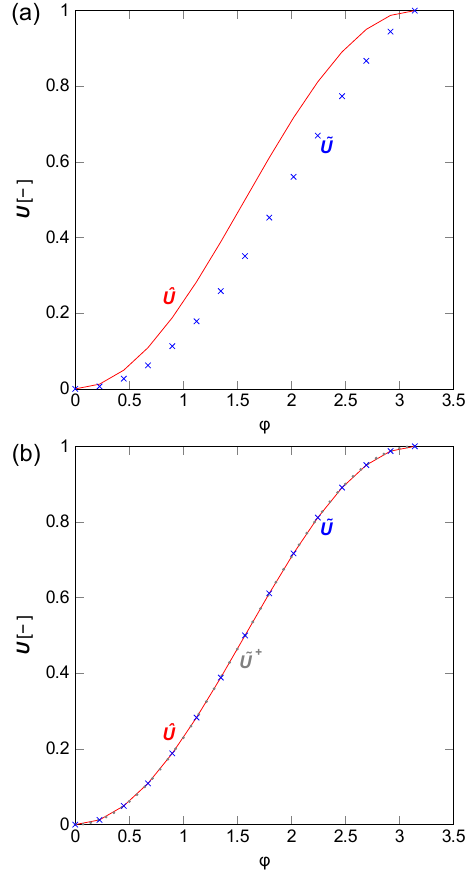
Figure 9. Example 2: target energy-path ˆ U (red line), normalized actual energy-path e U (blue crosses) and normalized actual energy + path at smaller increments e U (grey dots). (a) Initial shape and (b) optimum